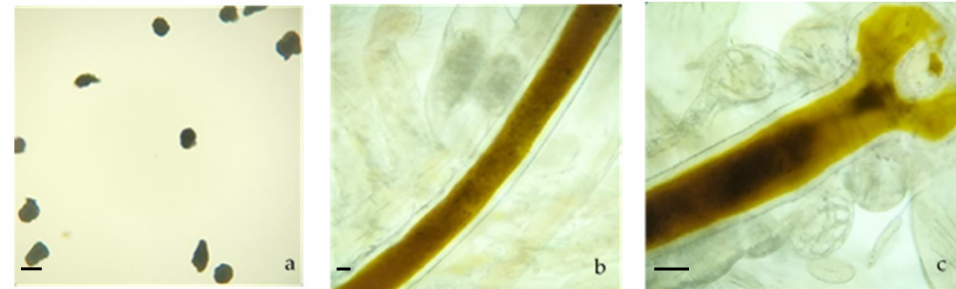
Figure 1. MPs and Artemia salina : ( a ) MPs used in the tests, ( b ) Artemia salina control without MPs after 48 h and ( c ) Artemia salina mouth control without MPs after 48 h. Scale bar ( a – c ): 200 µ m.